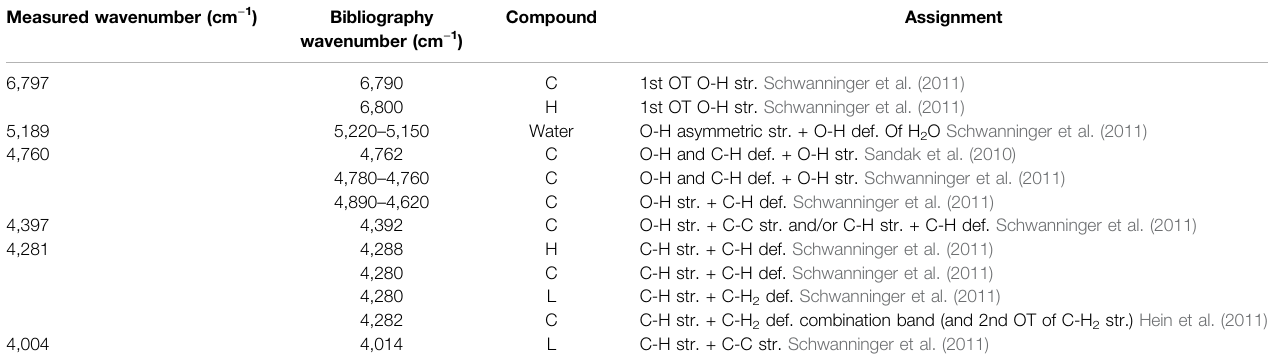
TABLE 3 | Near-infrared absorption band assignment associated with the most important wavenumbers (str.: stretching; def.: deformation; OT: overtone; L: lignin; H: hemicellulose; C: cellulose). Measured wavenumber (cm − 1